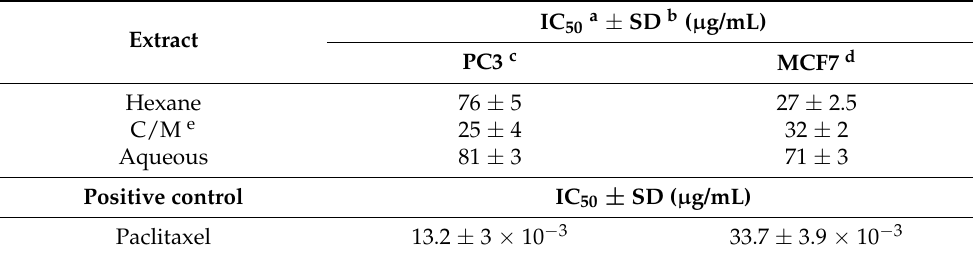
Table 1. Cytotoxic activity of H. glomerata extracts.